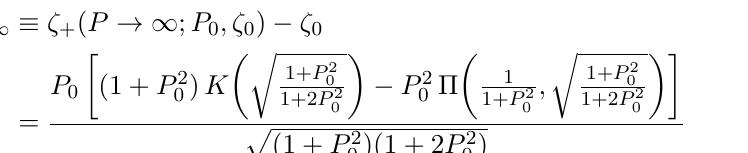
, there are two minimal surfaces anchored 1